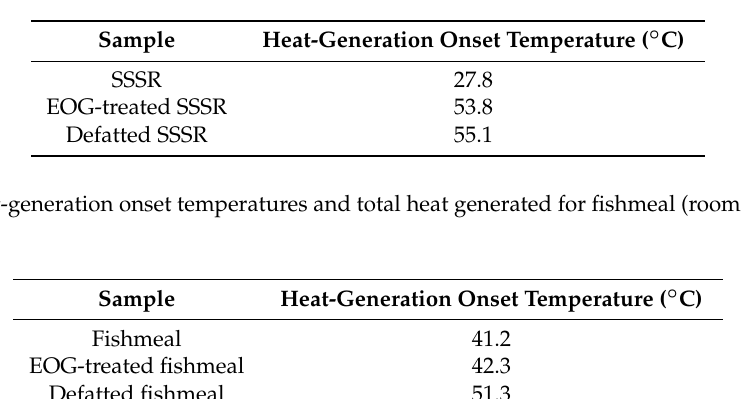
Table 2. Heat-generation onset temperatures and total heat generated for SSSR (soy sauce squeezing residue) (room temperature to 100 ◦ C).